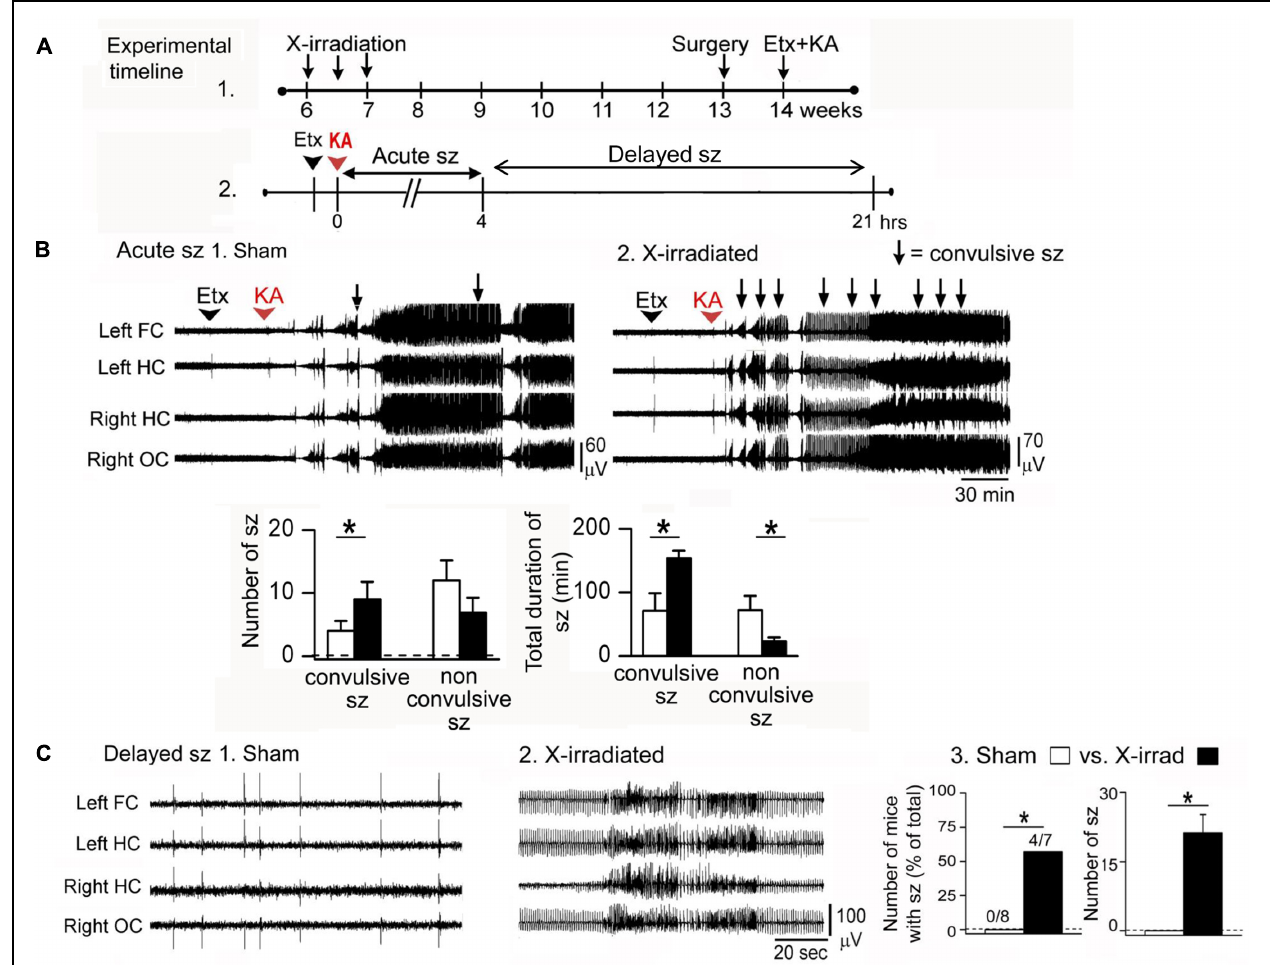
FIGURE 2 | Ablation of adult-born GCs leads to an increased effect of the convulsant kainic acid. (A) (1) Effects of kainic acid (KA) were tested in mice that had three sessions of focal X-irradiation and then were implanted with electrodes. After 1 week for recovery from electrode implantation, mice were injected with KA. (2) Effects of KA were characterized as ‘acute’ (Acute sz), referring to the first 4 h after injection when seizures were severe and occurred with brief interseizure intervals. Effects of KA also were examined after this acute period, when intermittent interictal spiking occurred. In some cases there were seizures, which are referred to as delayed seizures (Delayed sz). (B) In the acute period after KA injection, mice with reduced adult neurogenesis had more convulsive seizures and the total duration of all convulsive seizures was increased compared to sham-irradiated mice. There were fewer